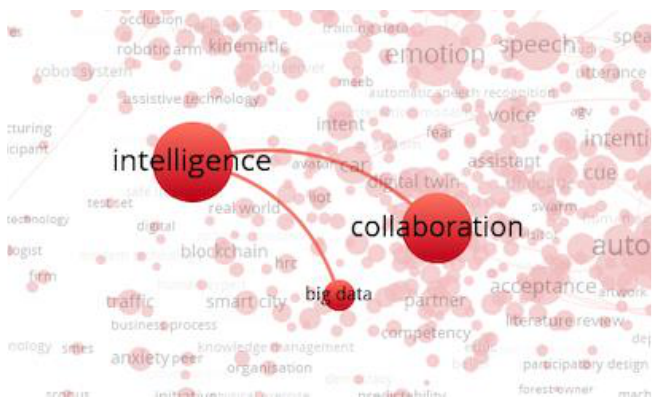
Figure 10. Intelligence dependency.